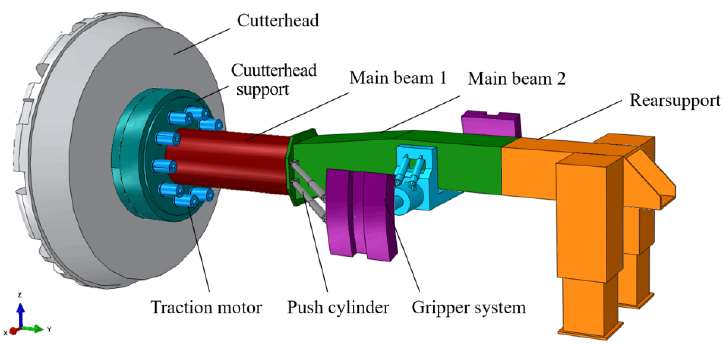
Figure 10. Structure diagram of TBM.